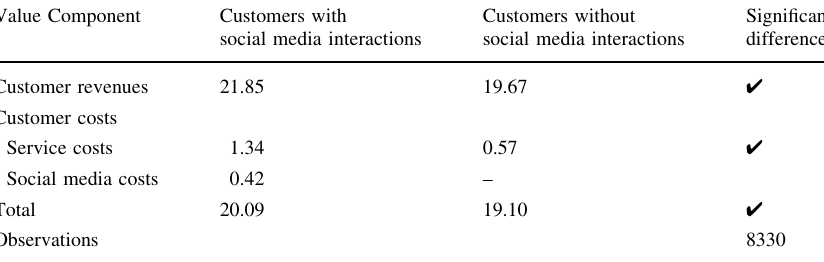
Table 8 Comparison of customer revenues and